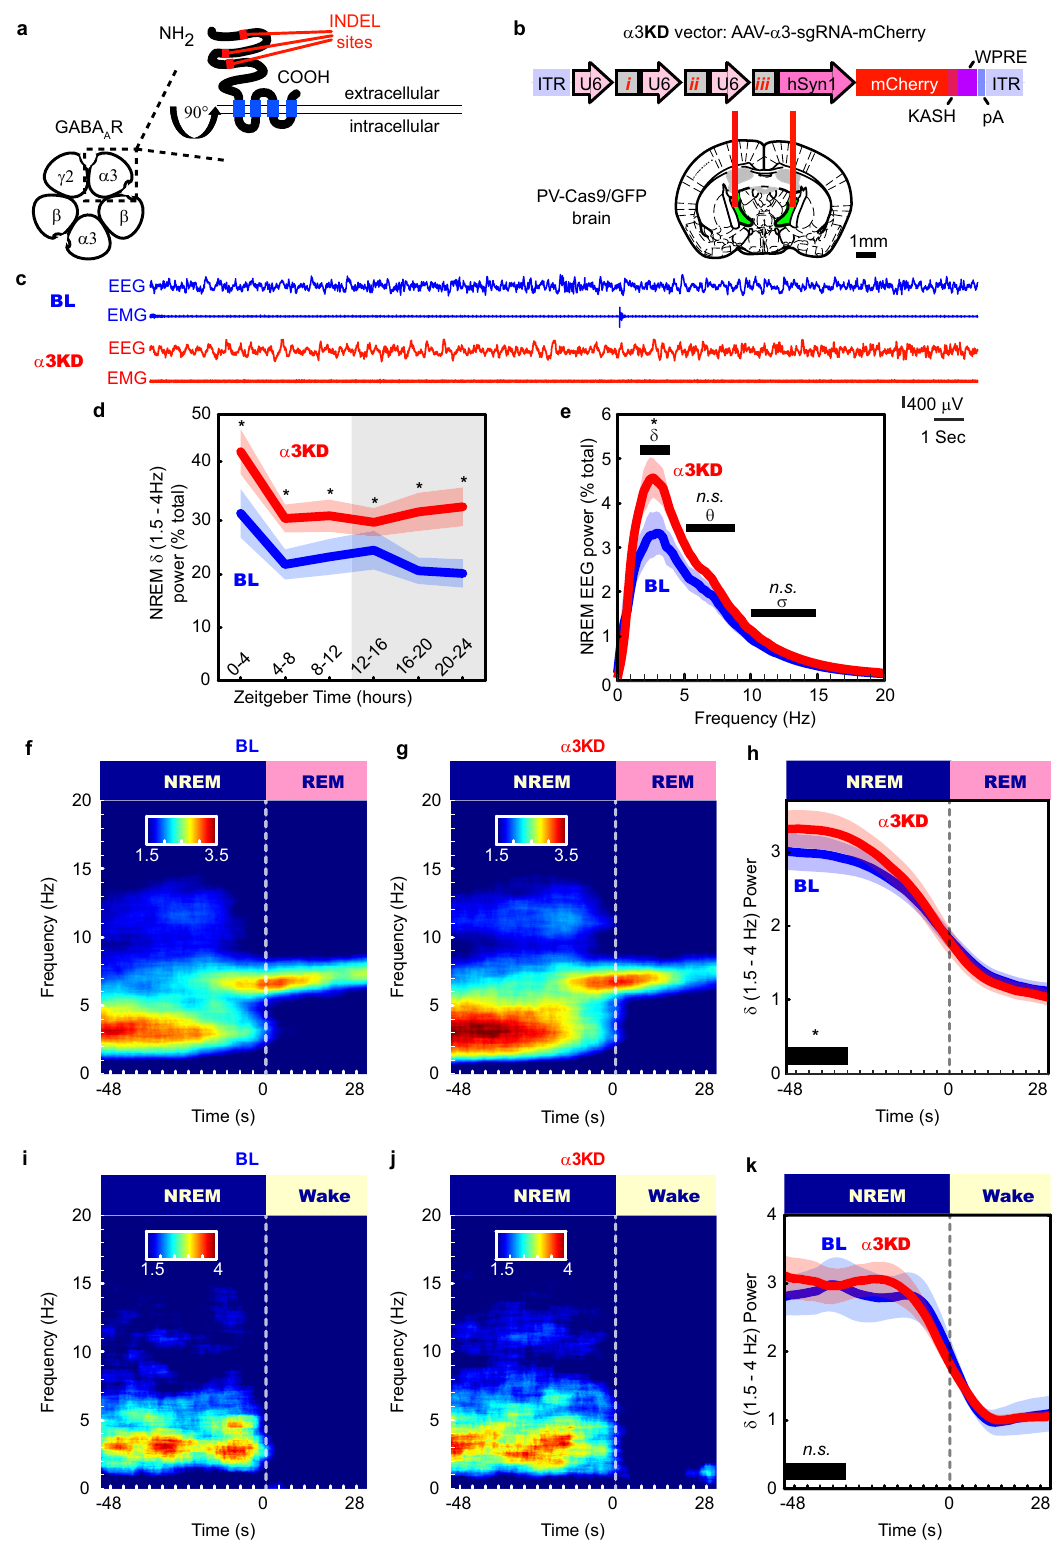
shorter NREM episode duration prior to NREM-wake transitions compared with the longer NREM preceding REM sleep. This prediction was con fi rmed since NREM episodes leading to wakefulness were shorter (76.3 ± 7.1 s) than those which transi- tioned into REM sleep (253.2 ± 30.9